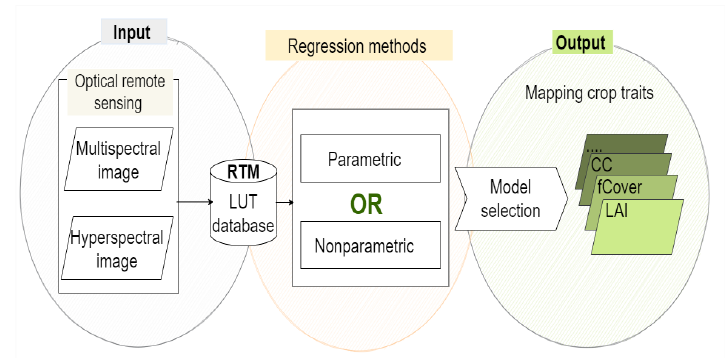
Figure 1. General workflow for the hybrid retrieval